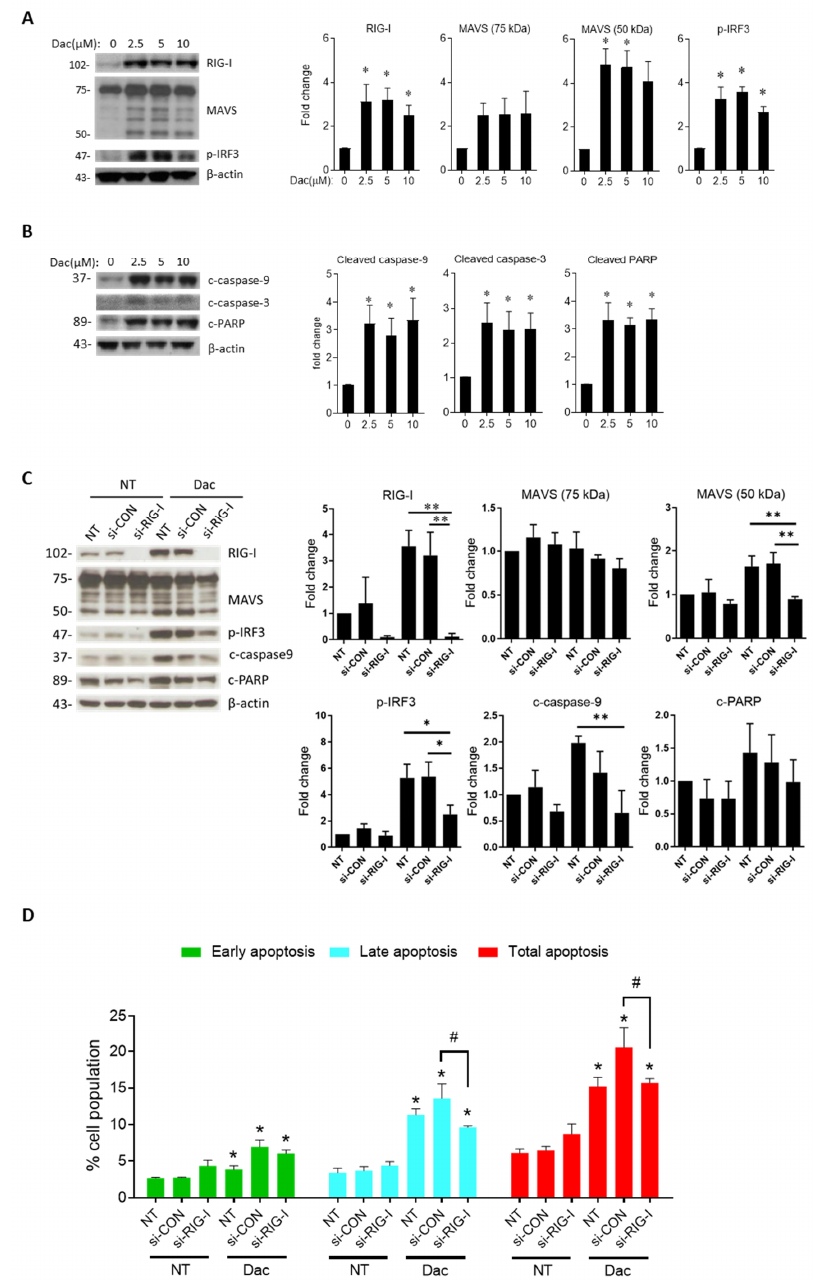
Figure 2. Dose manner of innate immune response and apoptosis signaling under Dac treatment. For dose manner test, SK-N-AS cells were treated with Dac from 0 to 10 µ M for 5 days. For siRNA-treated experiments, SK-N-AS cells were treated with or without 2.5- µ M Dac for 5 days. Representative western blot result and histogram of densitometric quantification data of innate immune response markers RIG-I, MAVS and p-IRF3 ( A ) and apoptotic signaling cleaved caspase-9, -3 and poly [ADP-ribose] polymerase (PARP) ( B ); β -actin serves as loading control; ( C ) cells transfected with siRNA control sequence (si-con) or siRNA-targeting RIG-I (si-RIG-I) or no treatment (NT) for 1 day followed by being treated with 2.5- µ M Dac for 5 days. Representative western blot results of RIG-I, MAVS, p-IRF3, cleaved caspase-9 and PARP are shown. β -actin serves as the loading control. * p < 0.05, ** p < 0.01 between indicated groups; ( D ) Cell apoptosis rate was measured using annexin V / PI staining by flow cytometry from at least three independent experiments. * p < 0.05 Dac group compared with corresponding NT group. # p < 0.05 between indicated groups.